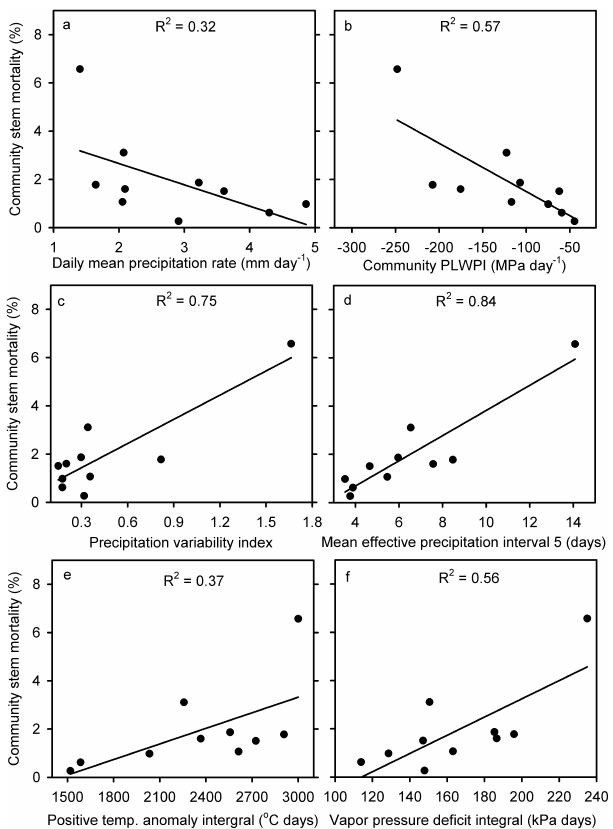
Figure 8. The mortality of the plant community as a whole ex- pressed relative to the stem number density of 2005 as a function of the previous year’s daily mean precipitation rate (a) , PLWPI at the community level (b) , precipitation variability index (c) , mean effective precipitation interval with a threshold daily precipitation rate of 5mm day − 1 (d) , positive temperature anomaly integral (e) , and vapor pressure deficit integral (f) . Fittings are linear.